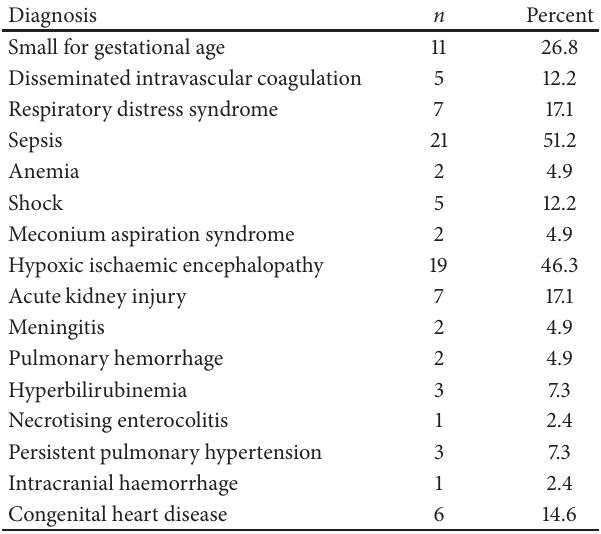
Table 1: Distribution of diagnosis in the study group ( 𝑁 = 41 ).